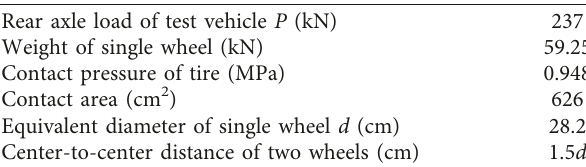
Table 2: Parameter of test